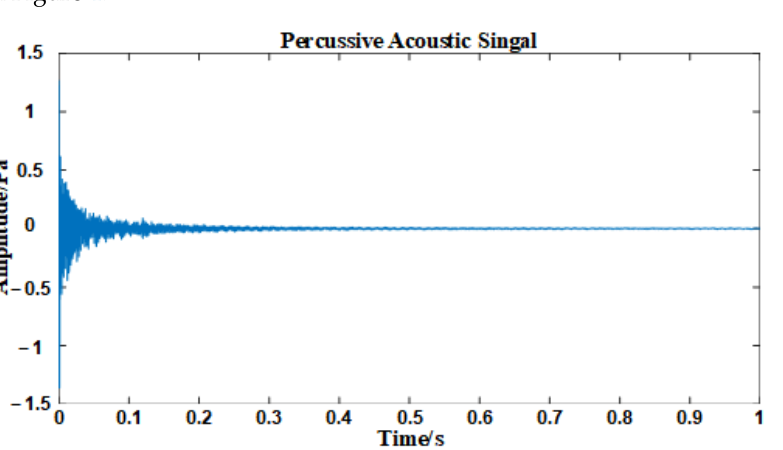
Figure 4. One of the sound signals recorded by the microphone.